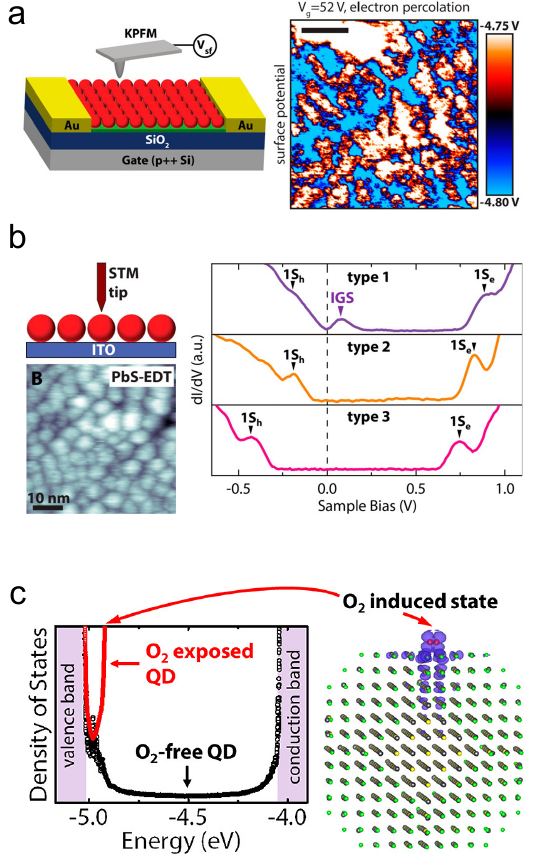
Figure 7. Oxygen-related doping mechanisms: ( a ) KPFM characterization of percolation pathways by in-gap states in PbS QD solid. ( b ) STM characterization of in-gap states in PbS QD solid. Reprinted with permission from [106]. Copyright 2015 American Chemical Society. ( c ) Illustration of in-gap states induced by molecular oxygen. Reprinted with permission from [107]. Copyright 2015 American Chemical